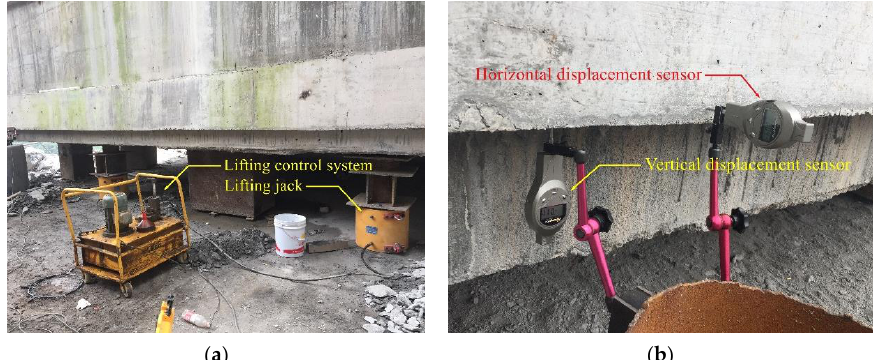
Figure 11. ( a ) Lifting system; ( b ) displacement sensors.